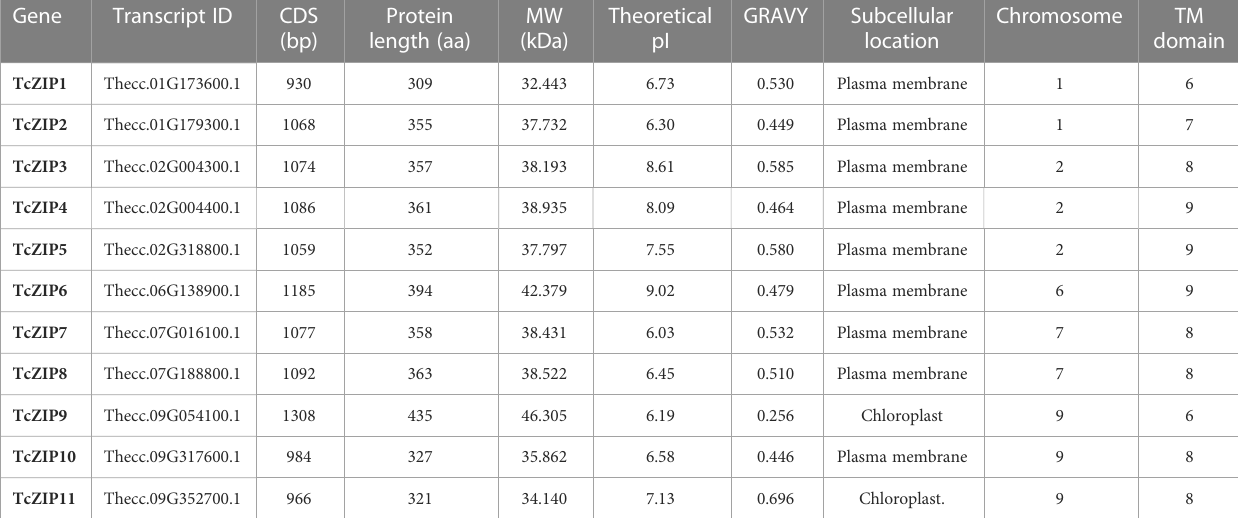
Protein MW Theoretical GRAVY Subcellular Chromosome TM (bp) length (aa) (kDa) pI location